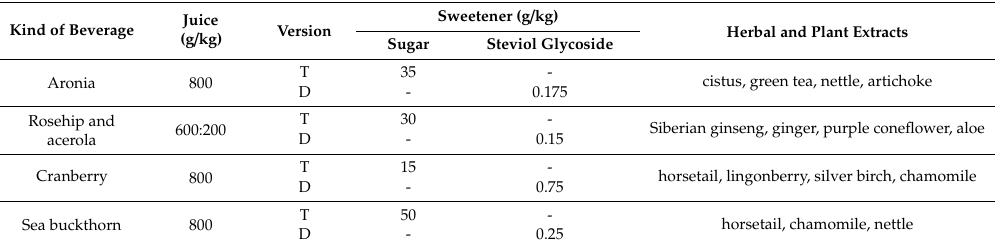
Table 1. Composition of fruit-herbal functional